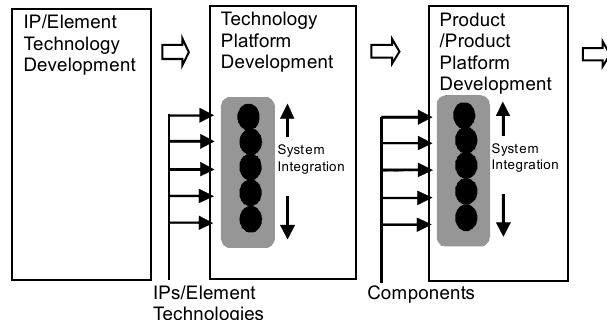
Figure 1. System integration in modularization of interfirm development